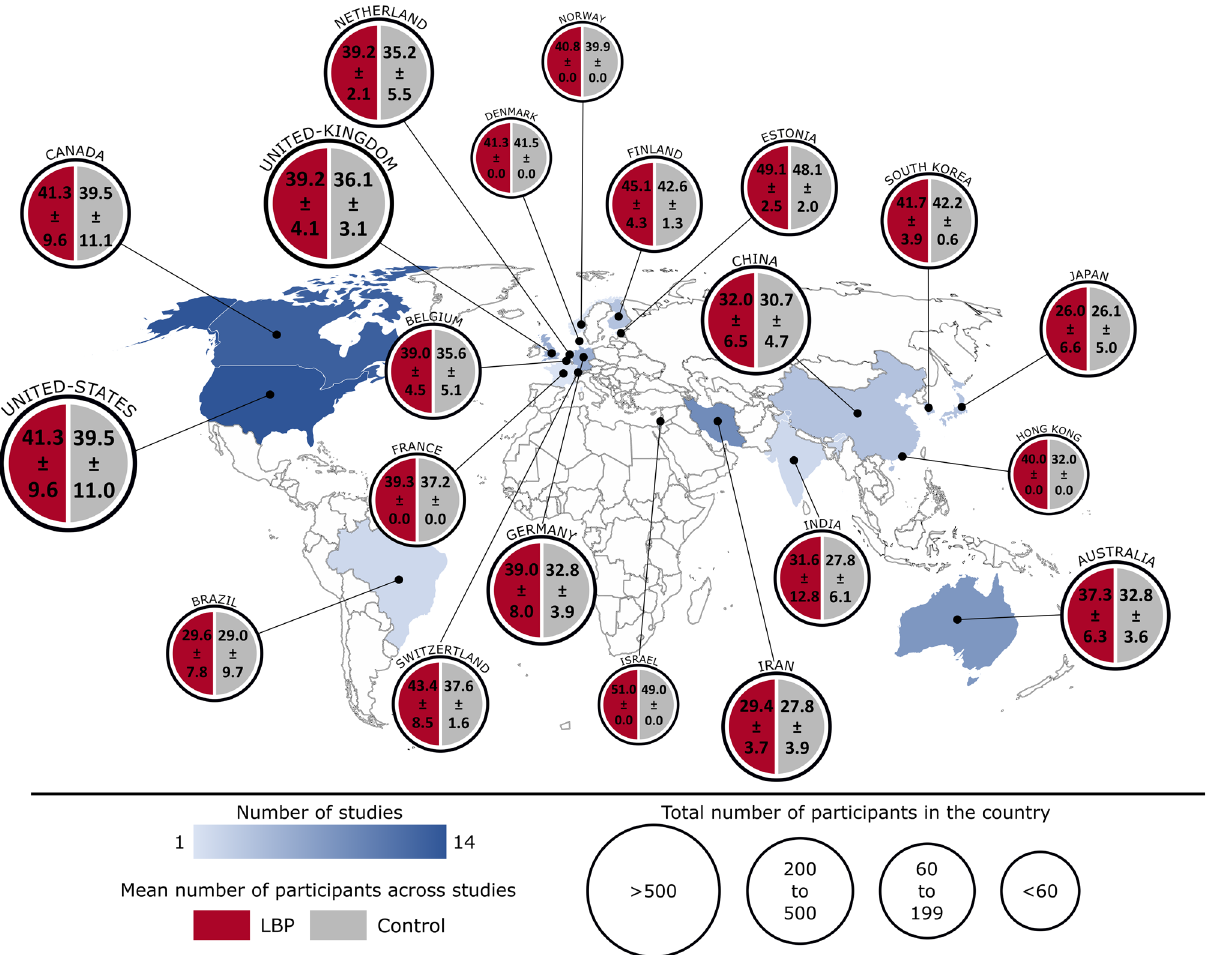
Figure 2. Labelled world map reporting the number of studies and the number of participants (NSCLBP and control) for each country of